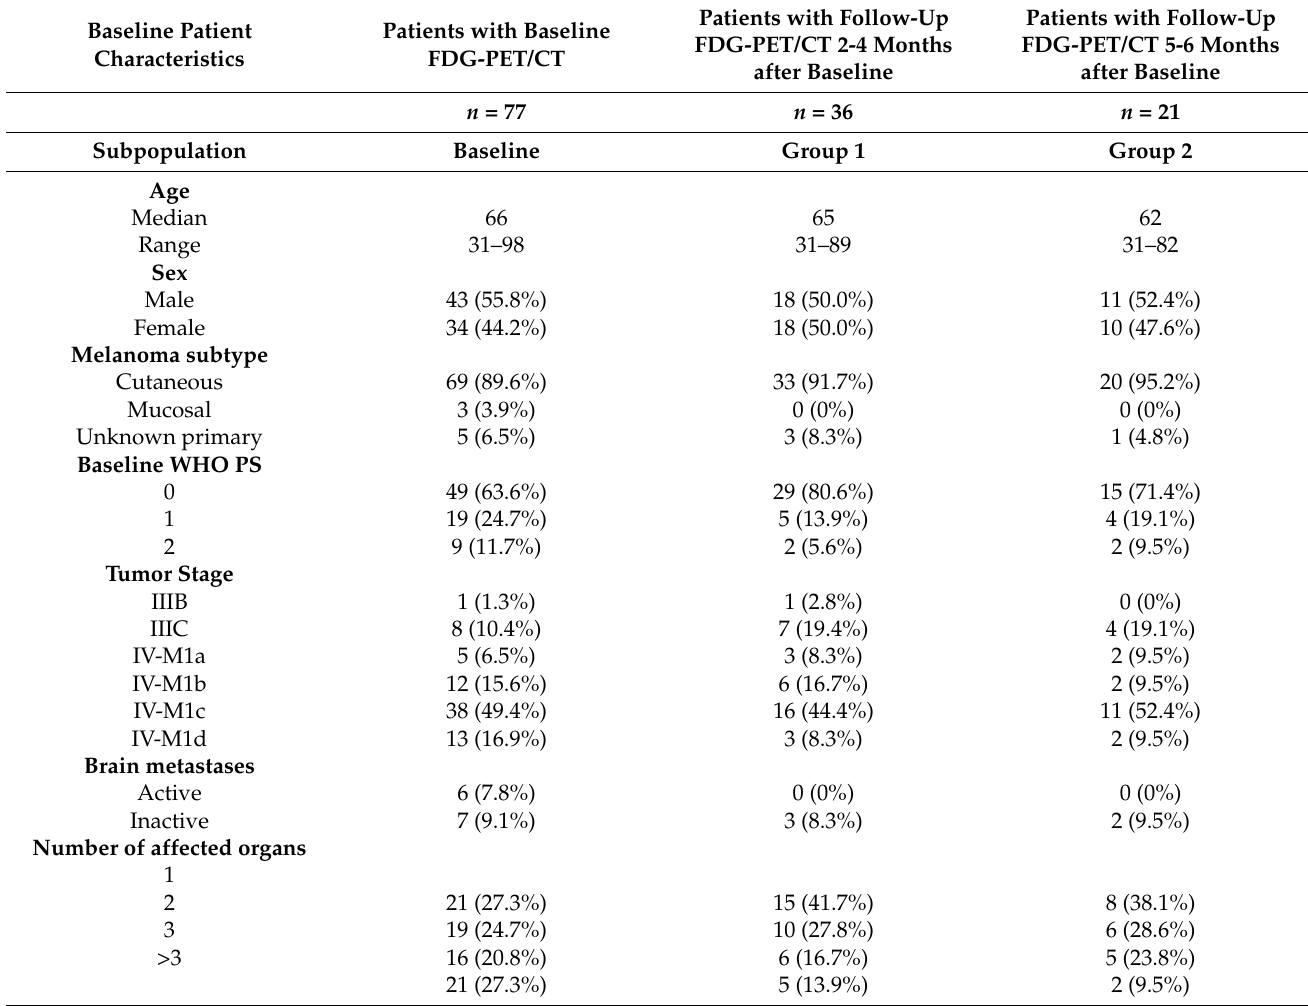
Table 1. Summary of baseline patient characteristics in all subgroups. Tumor stage was determined by the American Joint Committee on Cancer TNM 8th edition. Active brain metastases are defined as symptomatic. Baseline